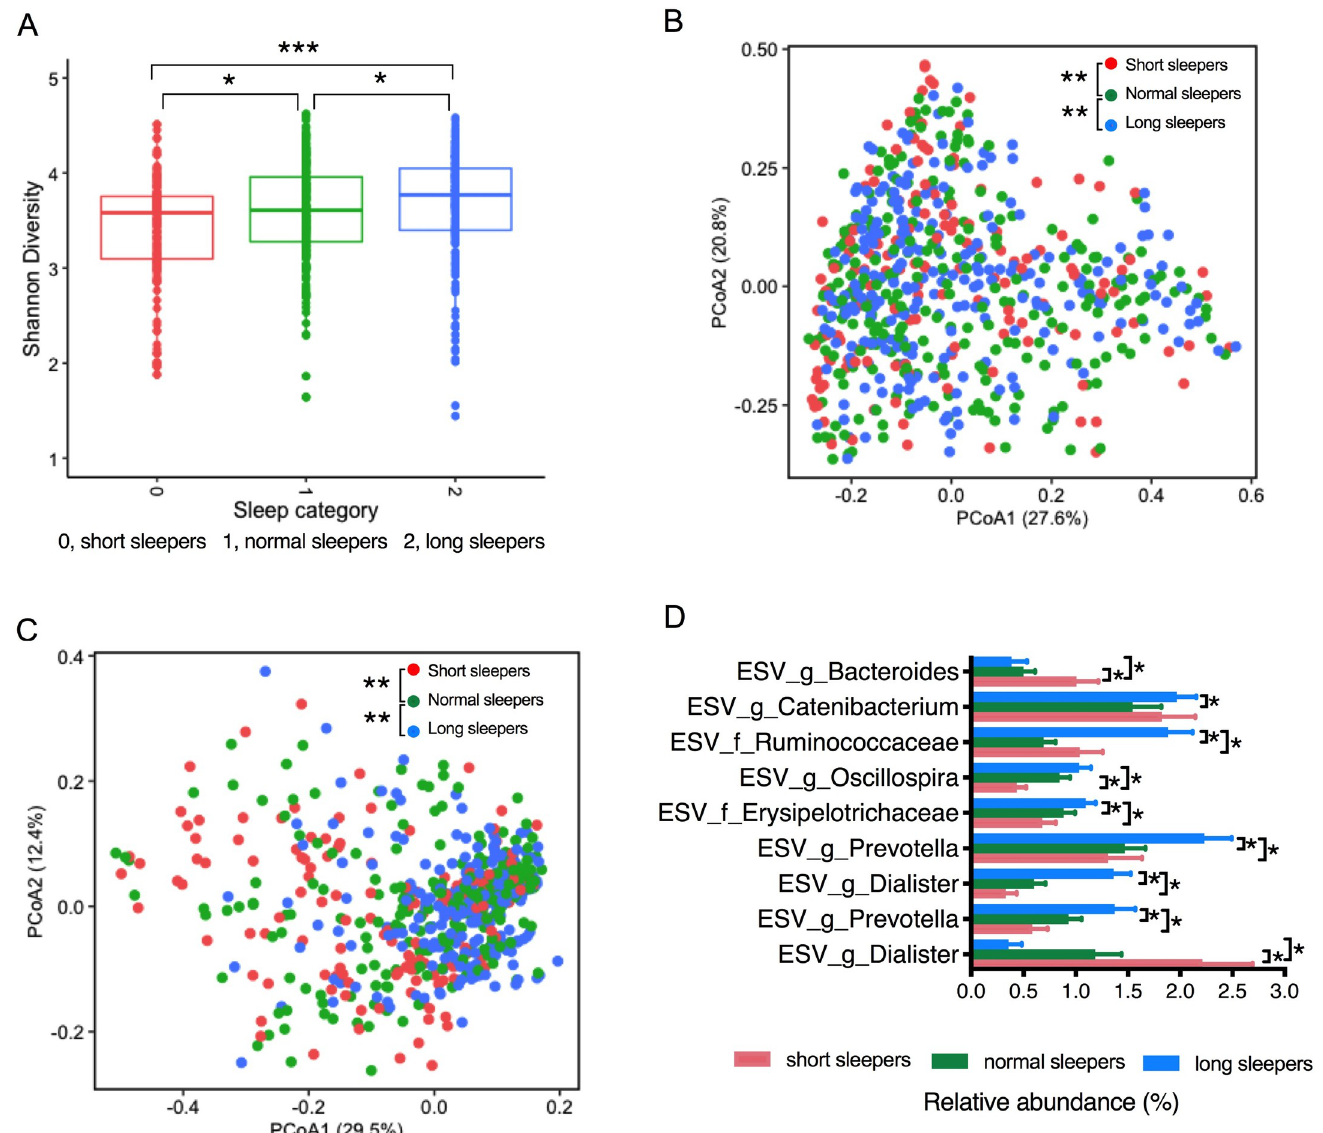
Fig 1. Sleep length can significantly impact intestinal microbiota community structure. (A) Alpha diversity (Shannon index) between different sleep groups; � p < 0.05; ��� p < 0.001. (B) Beta diversity analysis (weighted UniFrac distance) between different sleep groups; (C) Beta diversity analysis (unweighted UniFrac distance); and (D) Differential ESV abundance among short, normal and long sleepers, adjusted for BMI, age, gender and countries. ESVs with relative abundance � 1% in at least one group shown. Data shown are means ± S.E.M.; � p(fdr-corrected) < 0.05. fdr, false discovery rate.